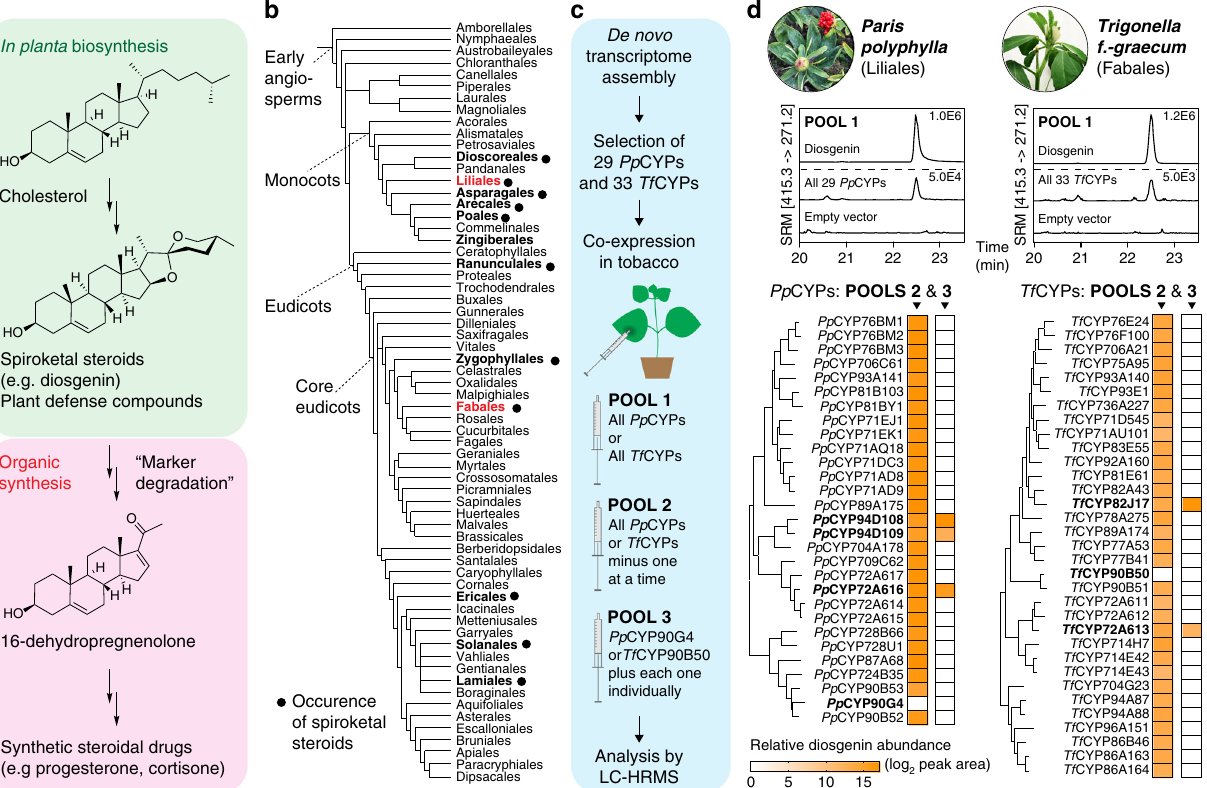
Fig. 1 Identi fi cation of diosgenin-biosynthetic cytochrome P450s using pooled-screen approach. a Diosgenin is biosynthetically derived from cholesterol, and used as the precursor for the synthetic production of steroidal drugs via “ Marker degradation ” 14 . b Phylogenetic relationship of plant families that reportedly harbor spiroketal steroid chemotypes. P. polyphylla and the T. fenum – graecum , belonging to Liliales and Fabales respectively, are the two species investigated in this study. Angiosperm phylogeny was obtained from Theodor C.H. Cole, Hartmut H. Hilger, and Peter F. Stevens. c The stepwise pooled- screen approach employed in this study to identity diosgenin-biosynthetic CYP s from P. polyphylla and T. fenum – graecum . The screens were conducted using the combinatorial transient gene expression system in Nicotiana benthamiana . d Identi fi cation of the diosgenin-biosynthetic CYP s from P. polyphylla and T. fenum – graecum . 29 CYP s from P. polyphylla ( PpCYP s) and 33 CYP s from T. foenum – graecum ( TfCYP s) were selected for the screens. In the initial